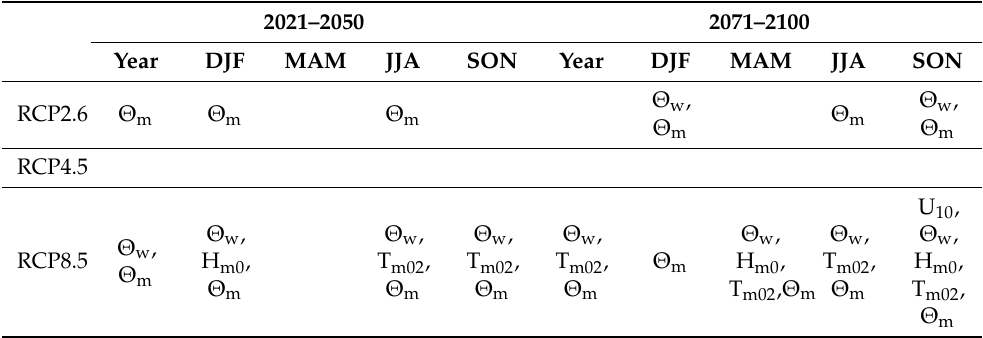
Table 3. Variables with future changes of the average wind and wave conditions (mean